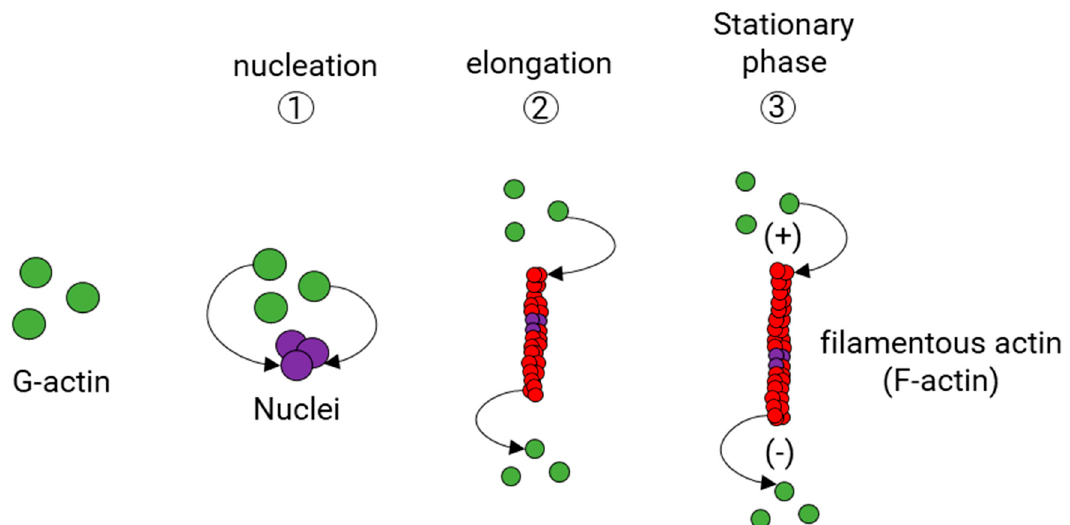
Figure 4. Polymerization of actin filaments. First, actin monomers linked to adenosine triphosphate (ATP) (G-actin, green) form an aggregate (violet) that grows exponentially by the addition of monomers to both ends of the filament (elongation phase). In the end, actin filaments reach a stationary state with G-actin, and actin filaments have a double-helical conformation.